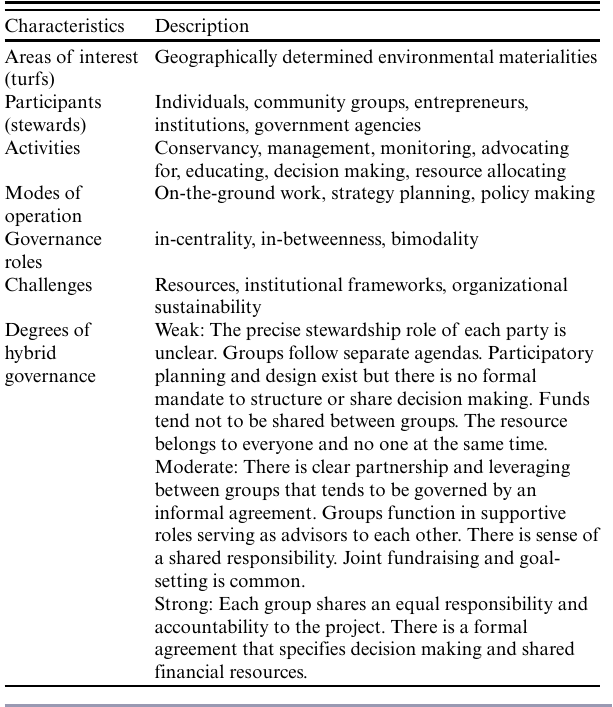
Table 1 . Conceptual framework of urban environmental stewardship as employed in this participatory action